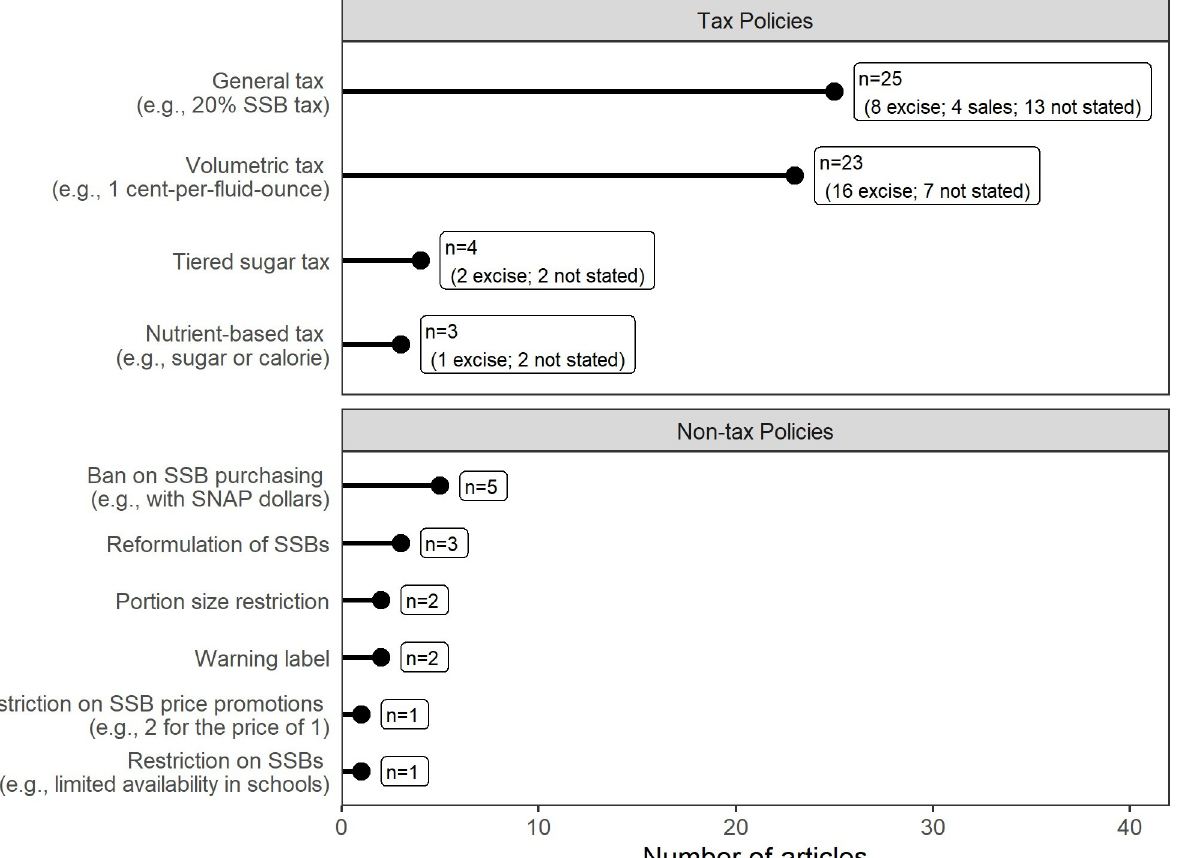
PLOS ONE | https://doi.org/10.1371/journal.pone.0275270 October 3,